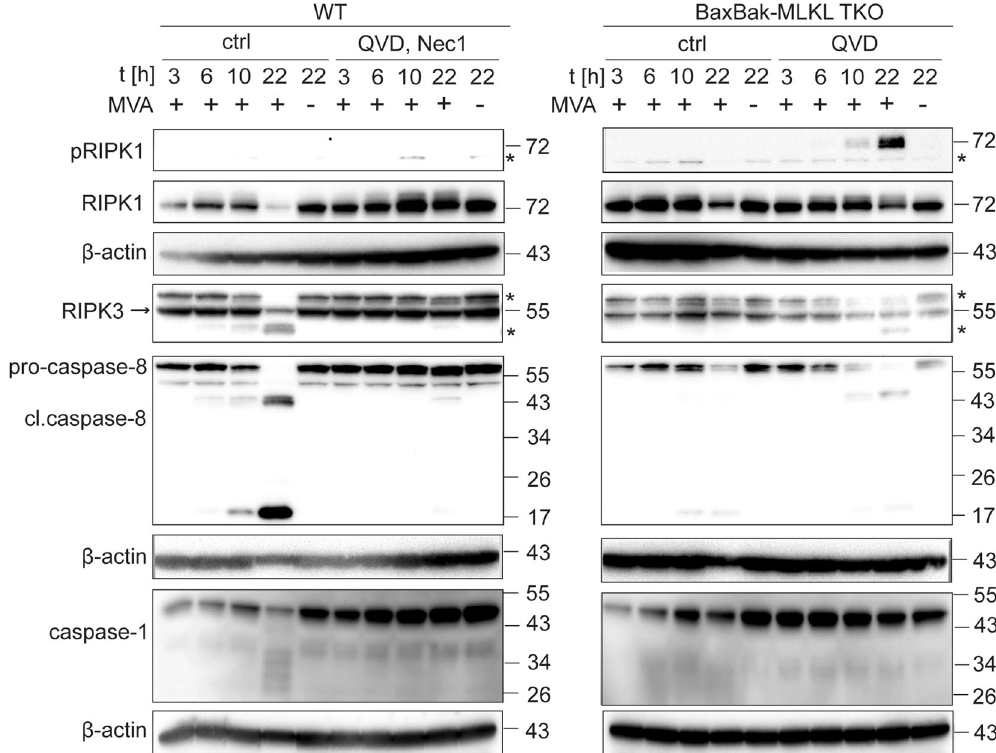
Fig. 2 Western blot analysis of cell death-associated signaling proteins upon MVA-infection in macrophages. D7 differentiated wt (left) or Bax/Bak/MLKLTKO (right) Hoxb8 macrophages were infected with MVA at an MOI of 2 and harvested at the indicated time points by accutase treatment. Cells were lysed in Laemmli sample buffer and samples were boiled at 95 °C for 5 min. Samples were subjected to SDS-PAGE on a 4 – 20% TRIS-glycine gel, transferred onto PVDF membranes, and probed with the antibodies indicated. Inhibitors were used at the following concentrations where indicated: QVD, 20 µM; Necrostatin-1 (Nec-1), 10 µM. β -actin served as a loading control. *unspeci fi c signal. Blots are representative of three independent